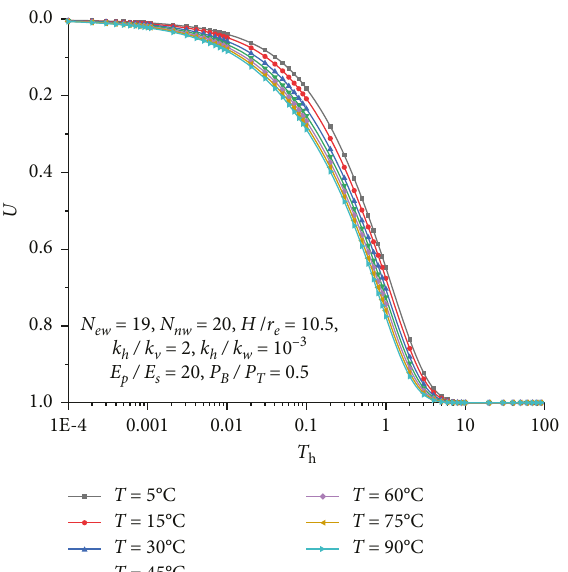
Figure 3: Influence of temperature on the consolidation process of foundation.